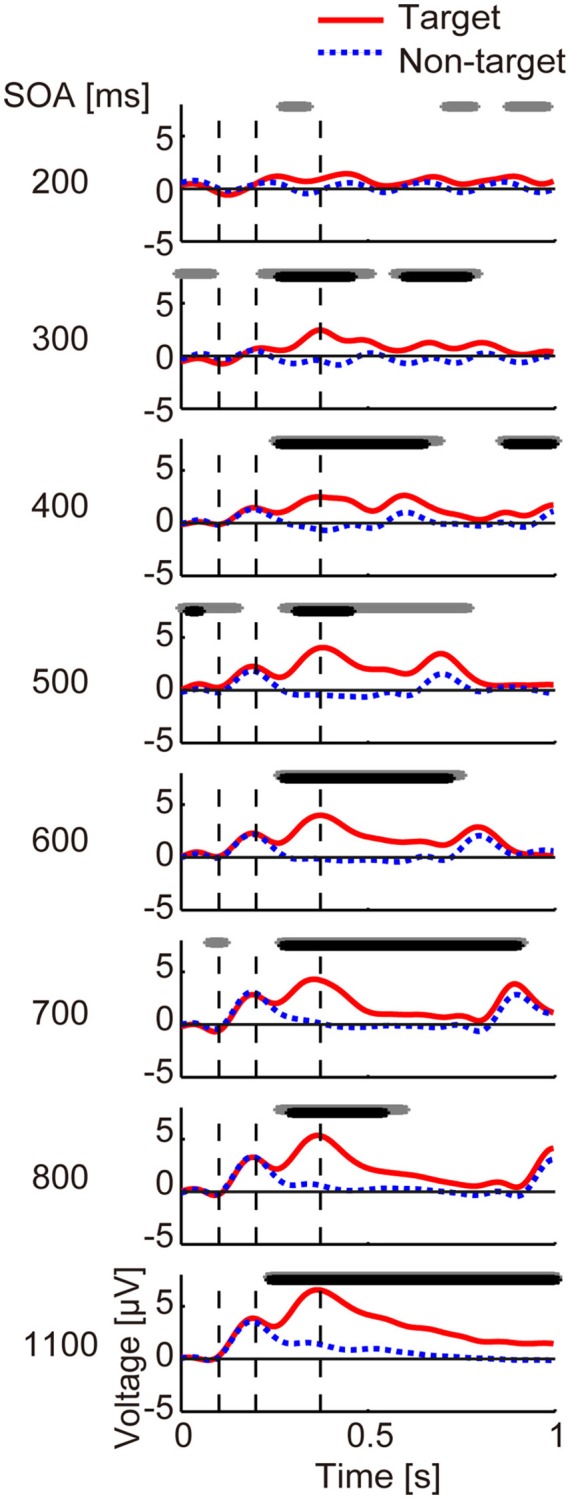
Averaged ERP data for each SOA. Averaged ERPs across participants at channel Pz from 0 to 1 s. The red line shows target data and the blue dashed line shows non-target data. The black and gray lines at the top of each panel represent duration, showing a significant difference between target and non-target data using paired t-tests (p < 0.05) with and without FDR correction, respectively. Vertical dashed lines show the averaged latencies (98, 203, and 375 ms; average across SOA conditions) at which positive or negative peaks occurred, each of which probably represents N100, P200, and P300, respectively.